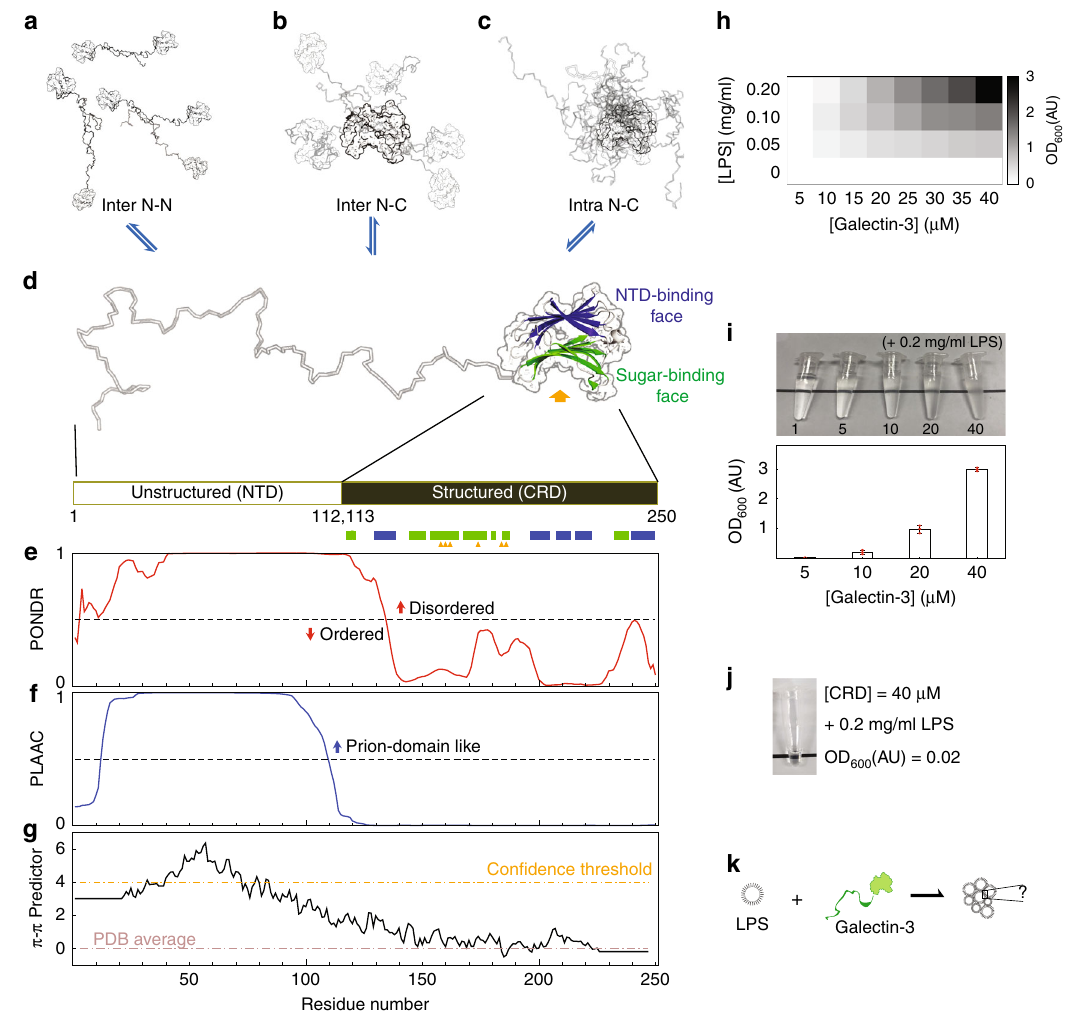
Fig. 1 Galectin-3 structure, sequence analysis and lipopolysaccharide (LPS) assay. a, b Intermolecular and ( c ) intramolecular galectin-3 interactions identi fi ed in a previous study. d A galectin-3 monomer: the structured carbohydrate recognition domain is represented by the solved crystal structure (PDB code, 2NMO), with the (non-canonical) N-terminal domain (NTD)-interaction face (with fi ve β -strands) colored blue and the (canonical) sugar binding face (with six β -strands) colored green. Sugar-speci fi c binding sites are indicated with yellow arrows. e – g Sequence analyses: ( e ) level of structural disorder (using PONDR 79 ), ( f ) similarity to prion-like proteins (using PLAAC) 53 , ( g ) propensity to form π – π interactions 54 . h , i Turbidity (O.D 600nm ) of LPS – galectin-3 samples measured at different protein and LPS concentrations. j Photograph of the CRD-only sample under the maximum